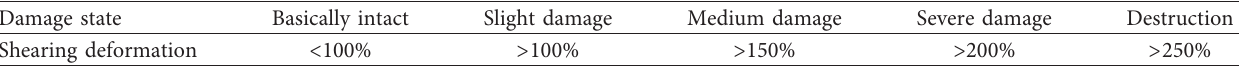
Table 4: Safety evaluation index of